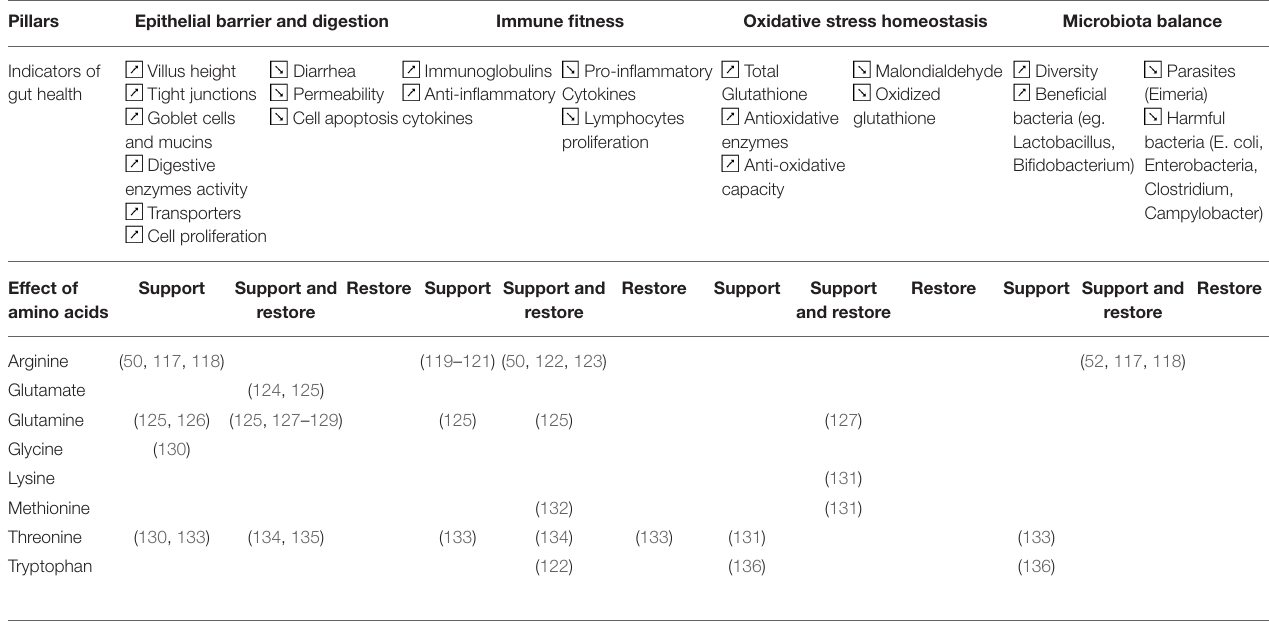
TABLE 2 | Amino acids influencing the indicators related to the 4 pillars of gut health in broiler chickens.